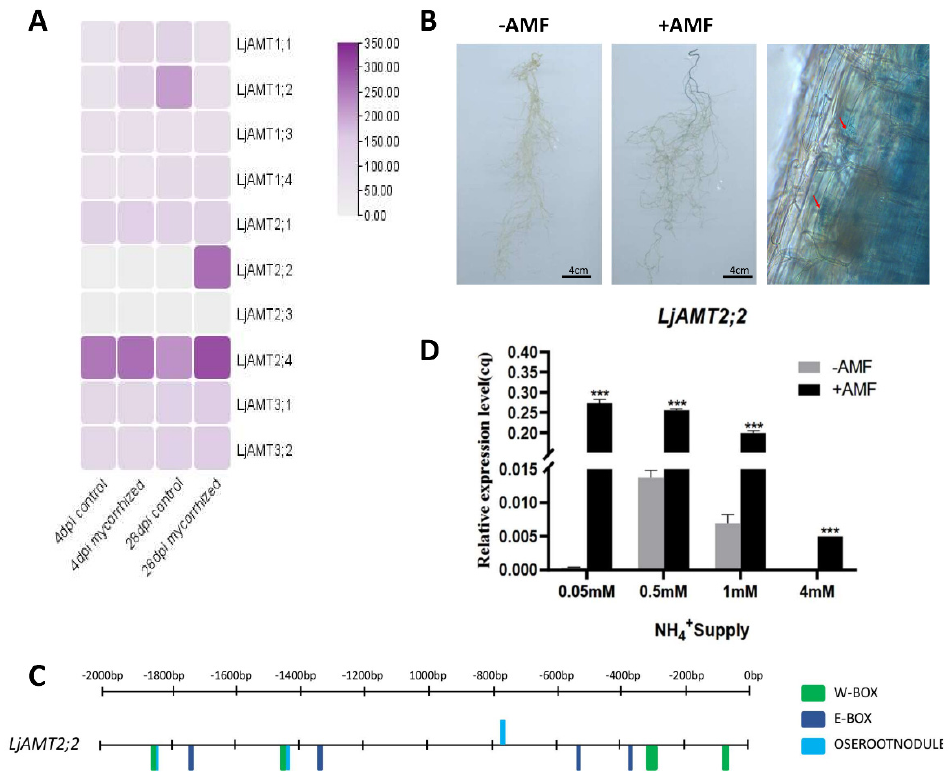
Figure 5. Mycorrhizal-inducible expression of the LjAMT2;2 gene. ( A ) Heatmap of the LjAMT family gene expression induced by AMF. ( B ) GUS expression induced by AMF in p LjAMT2;2 plants. Arrows indicate Gus expression positions ( C ) Analysis of cis-acting elements in the LjAMT2;2 gene promoter. ( D ) Expression of the LjAMT2;2 gene under symbiotic and non-symbiotic conditions. Data are means ± standard error (SE; n ≥ 3 biological replicates; *** p ≤ 0.001).